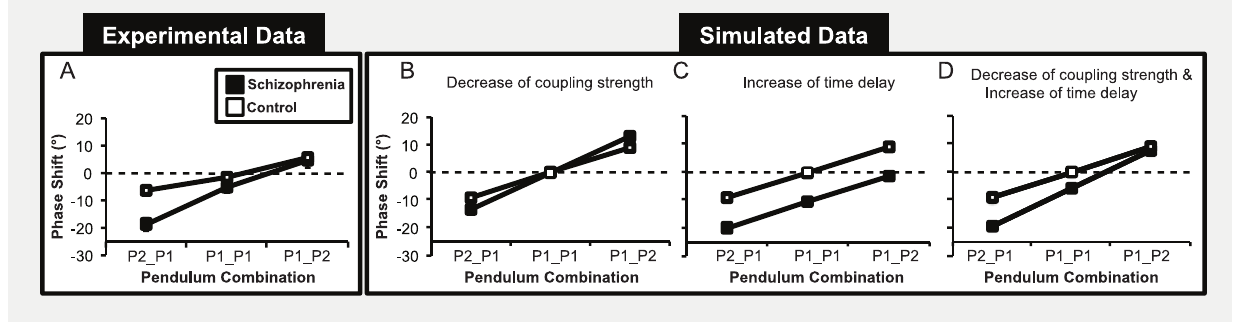
Figure 2. Phase shifts from the intended pattern of coordination as a function of the pendulum combination for the schizophrenia (black) and control groups (white). Phase shifts obtained experimentally (A) and in the simulations with a decrease of the coupling strength (B), with an increase of the time delay (C) and with both of them (D).